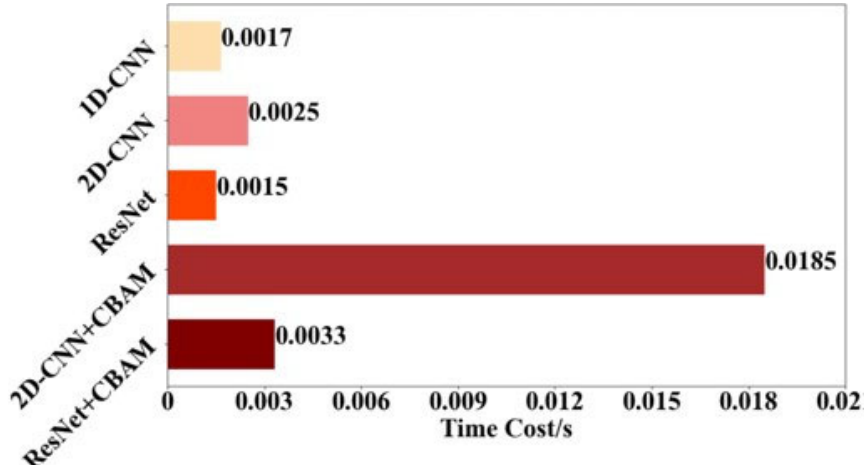
Figure 12. Time cost comparison of the five models for one sample on average. Notes: The test is on a commercial processor (GPU: GTX1080Ti, CPU: Intel i7 dual-core, Memory: 32G).